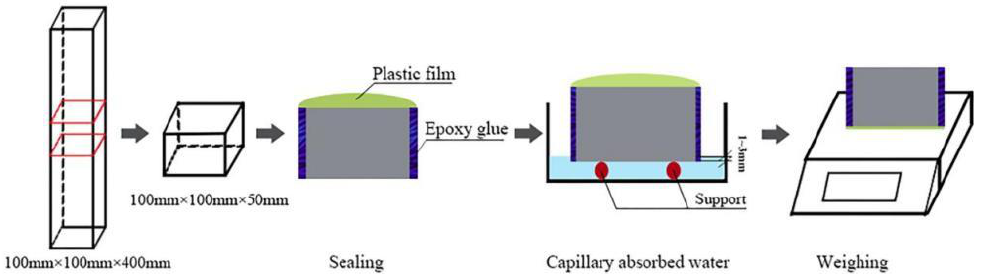
Figure 3. Capillary-water-absorption test flow chart. Table 7. Test time intervals and allowable errors.